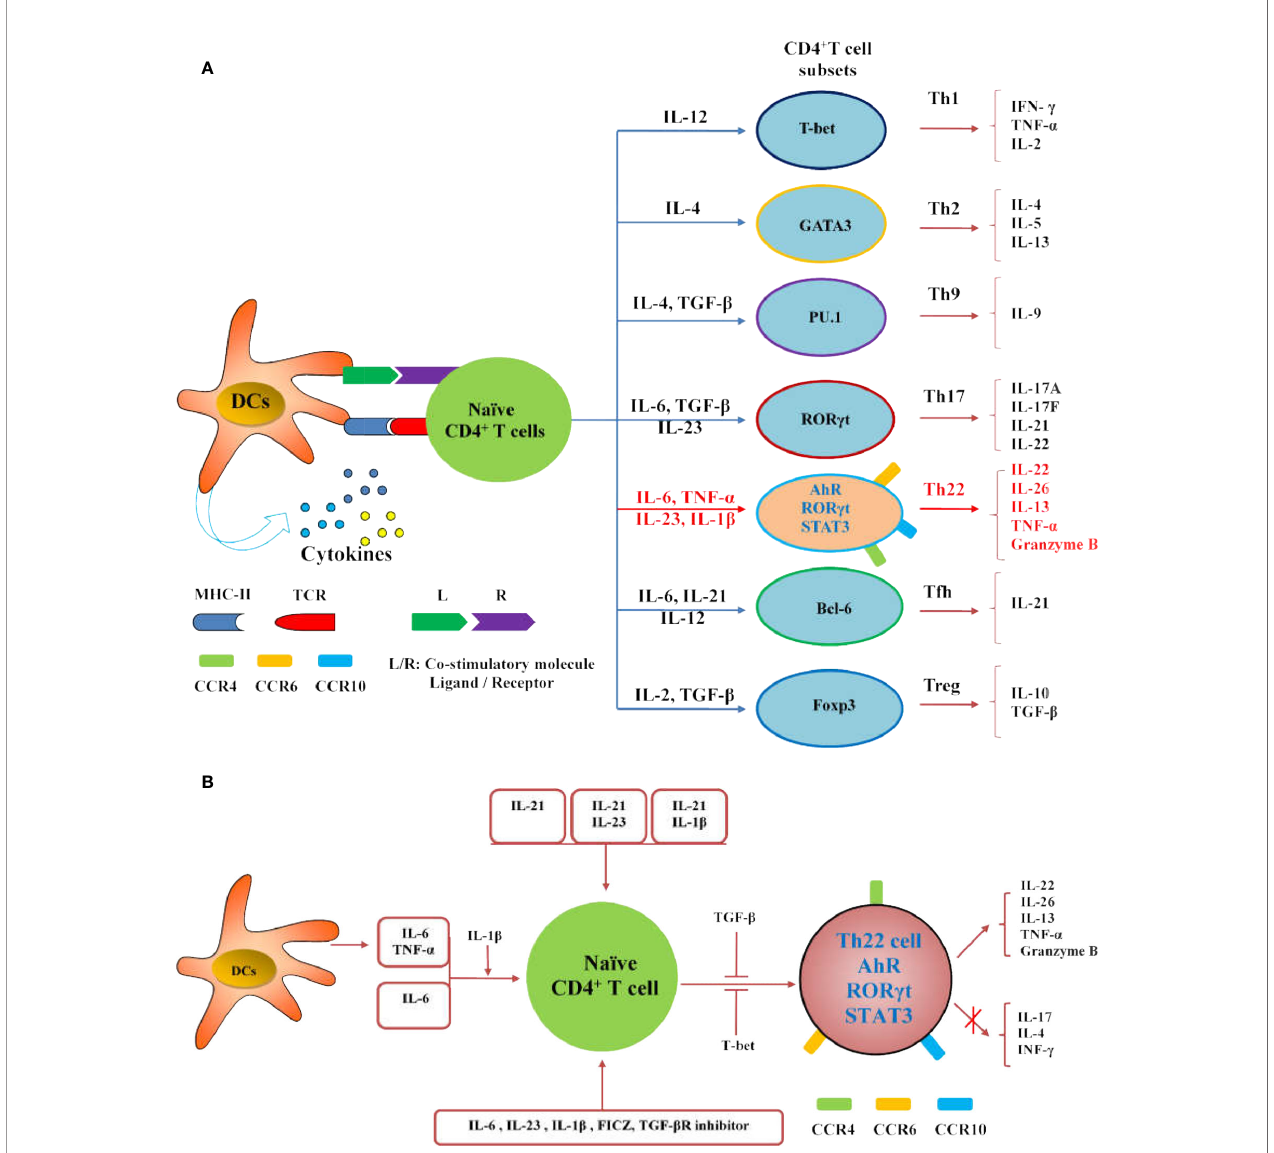
FIGURE 2 | Regulation of Th22 cells differentiation. (A) The diagram illustrates the differentiation of Th cell subsets from naïve CD4 + T cells. (B) IL-21, IL-21 combined with IL-23 or IL-1 b can induce the differentiation and IL-22 expression of Th22 cells; IL-6 and TNF- a secreted by DCs or external IL-6 or IL-6 and TNF- a can promote the differentiation of naïve CD4 + T cells into Th22 cells, and IL-1 b promotes the differentiation; IL-6, IL-23, IL-1 b , FICZ and TGF- b R inhibitor can promote the differentiation of naïve CD4 + T cells into Th22 cells. Both TGF- b and T-bet inhibit the expression of IL-22 in Th22